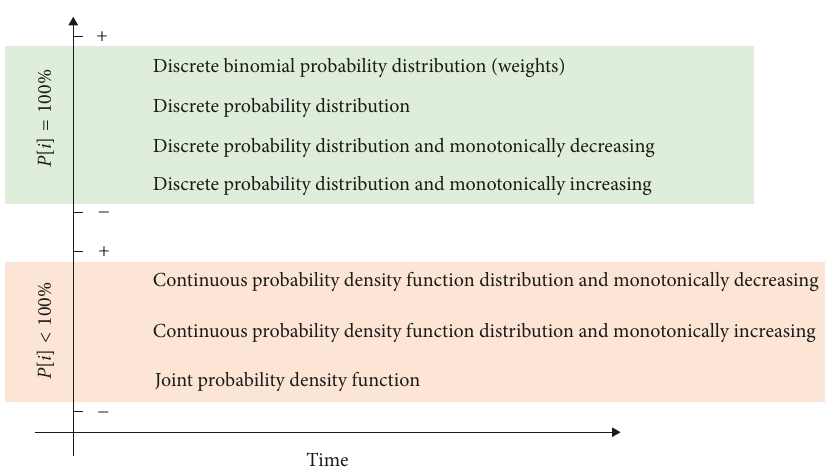
Figure 8: A representative graph of the distribution m of information and precision variance ( P ) approaching 100% and distributions m that are necessarily less than 100%. Distributions associated with ad hoc working methods can be redefined from the adaptive system that constitutes the workflow